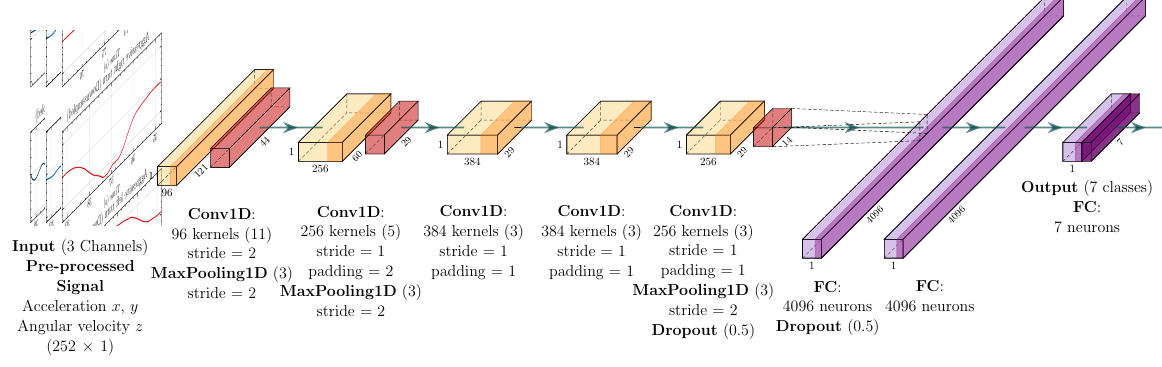
Figure 2. 1D-AlexNet architecture. Each block describes the parameters assigned to the respective layers, as for blocks “Conv1D” and “MaxPooling1D”, where the first value corresponds to the size of the